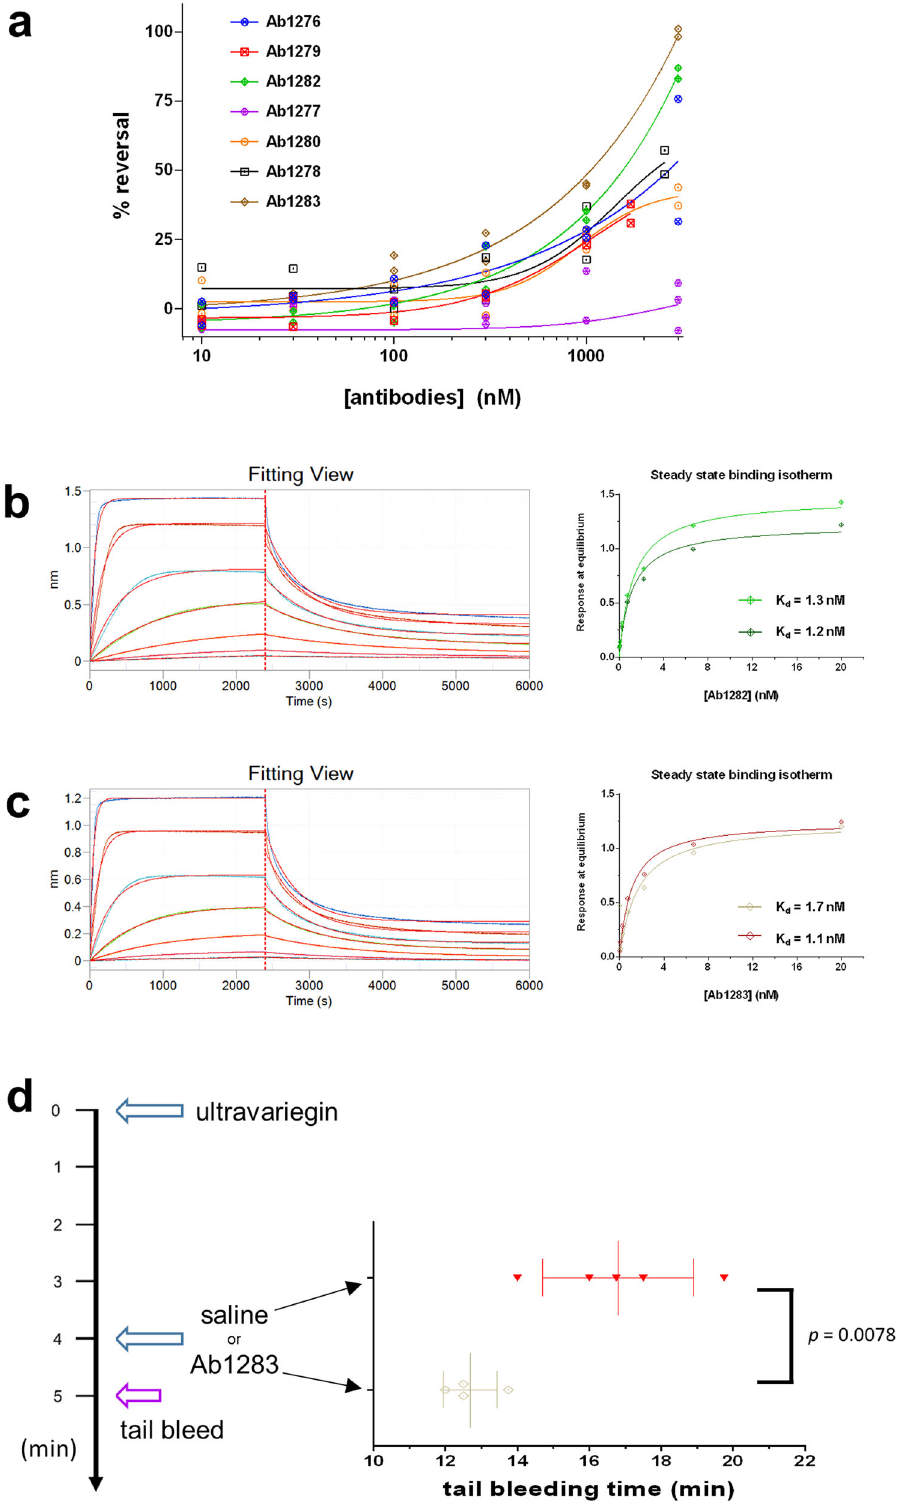
Fig. 7 Reversal agents for ultravariegin. a Antibodies discovered by screening against a human naive antibody phage-display library dose-dependently reversed ultravariegin ’ s (0.5 nM) inhibition of thrombin ’ s (0.8 nM) amidolytic activity ( n = 2 independent experiments for each antibodies, except Ab1277, for which n = 3). Representative BLI-binding sensorgrams between biotinylated ultravariegin and b Ab1282 or c Ab1283 fi tted to a 1:1 kinetic model. Concentrations of Ab1282 and Ab1283 used were 20, 6.7, 2.2, 0.74, 0.25, 0.082 and 0.027 nM in a series. Steady-state analyses were performed to obtain dissociation constant K D at equilibrium ( n = 2 independent BLI experiments). d Tail bleeding time from rats injected with 0.75 mg/kg ultravariegin at t = 0 min, and subsequently saline (red, n = 5) or 10 mg Ab1283 (beige, n = 4) at t = 4 min. P = 0.0078 from two-tailed Student ’ s t test between the two groups. The incision for tail bleed starts at t = 5 min. Data shown are mean ± SD.